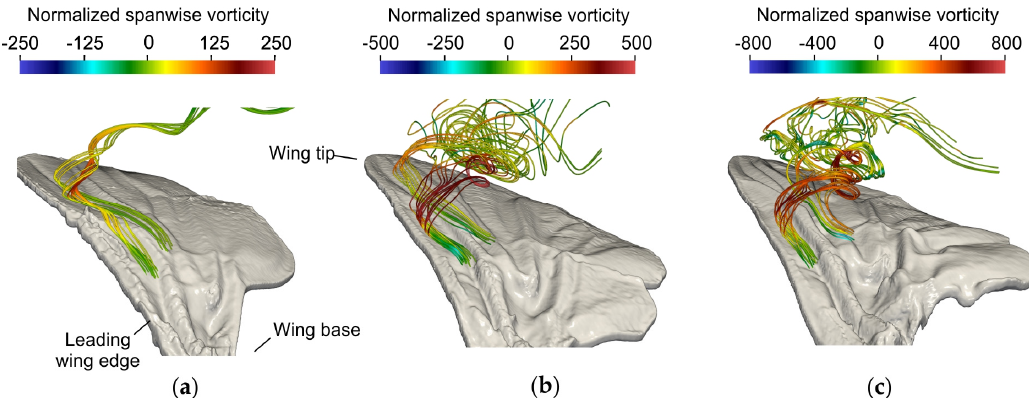
Figure 5. Flow pattern produced by natural wing models of three fly species. Color-coded instantaneous streamlines in ( a ) Drosophila , ( b ) Musca , and ( c ) Calliphora . Snapshots are taken at 1.3 ( Drosophila ) and 3.3 stroke cycle ( Musca, Calliphora ) after motion onset in natural wings [83]. Streamlines were computed from particles released in the corrugation valleys of the dorsal (upper) wing surface near the leading wing edge. Data show little spanwise vorticity inside the corrugation valley near the surface (arrows) and leading-edge vortex suction pulls the virtual particles away from the surface.